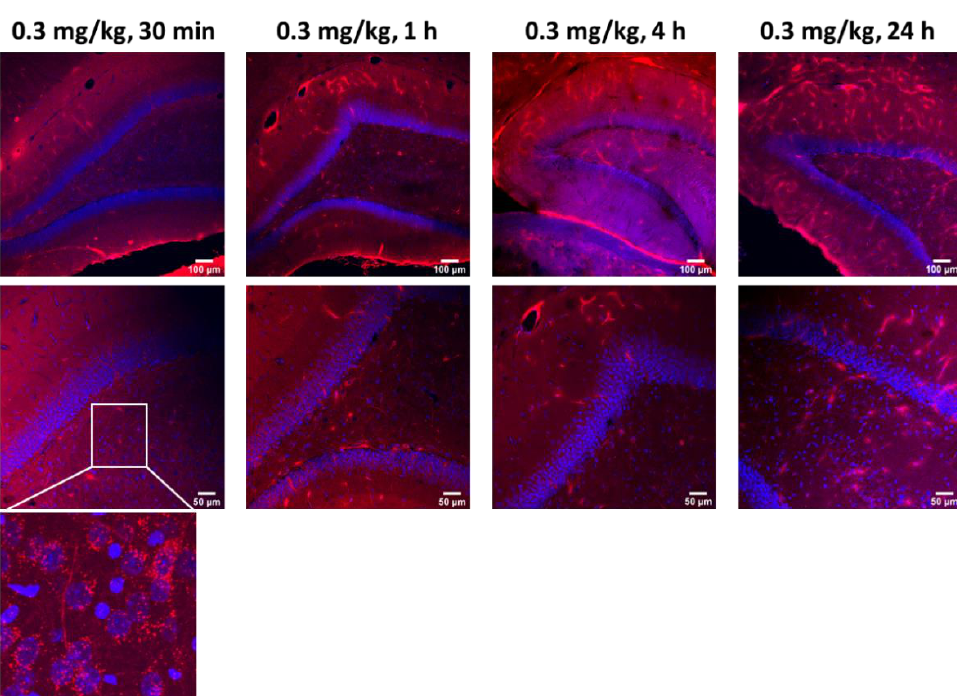
Figure 3. Intra-CSF Subcortical Biodistribution Data. The parent IgG1 antibody penetrated deep into the hippocampal parenchyma within 30 min of administration into the rat cisterna magna. Representative images. Intra-CSF delivery of ABT-806 at a dose of 0.3 mg/kg resulted in the penetration of the antibody into the deeper brain regions, including the hippocampus, as early as 30 min post injection. The antibody was still present in the subcortical regions after 24 h. Blue = DAPI, Red = ABT-806. n = 3 animals per timepoint.